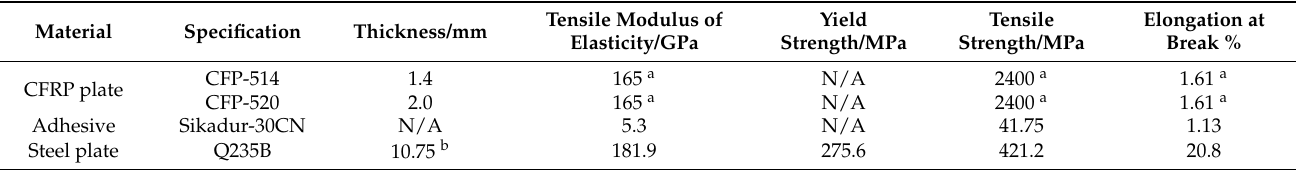
Table 1. Primary mechanical properties of the materials adopted in the fatigue